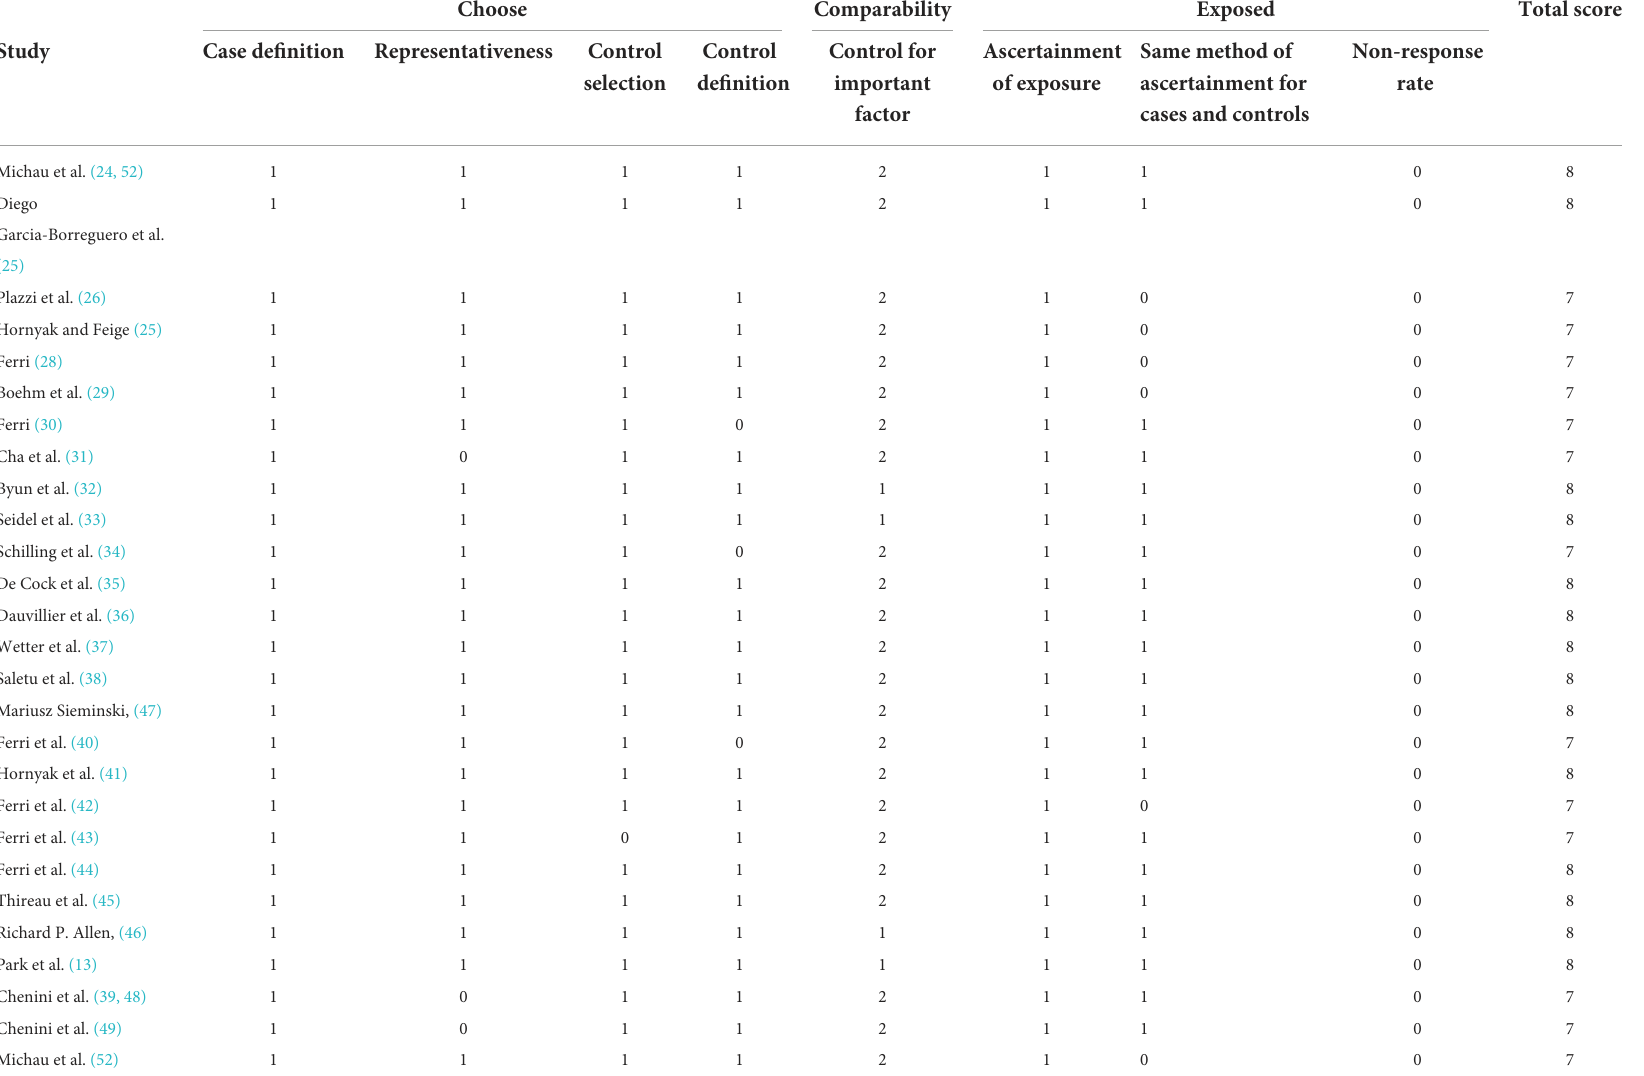
TABLE 2 Quality assessment of included